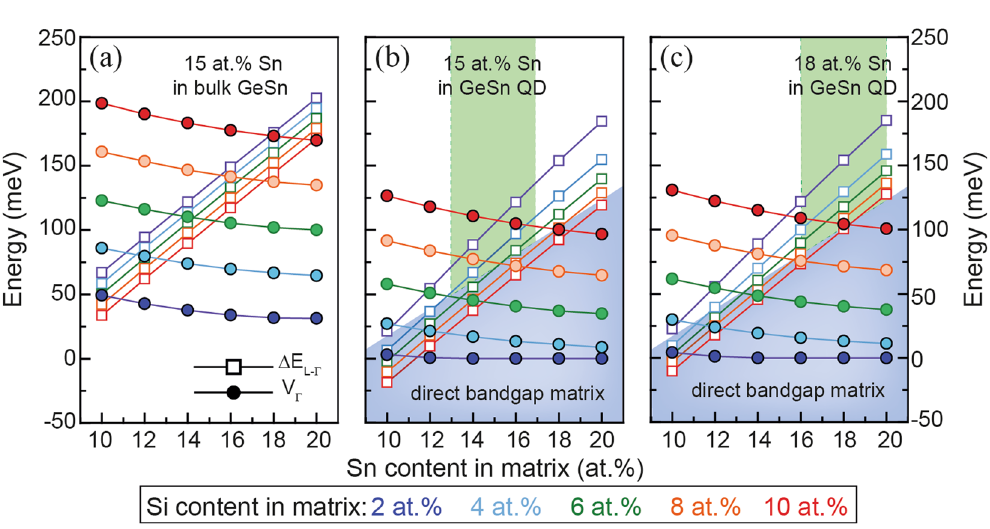
Figure 7. Directness of the potential well (empty squares) and band discontinuity at Γ (solid circles) for ( a ) bulk Ge 0.85 Sn 0.15 /SiGeSn, ( b ) a Ge 0.85 Sn 0.15 /SiGeSn QD and ( c ) Ge 0.82 Sn 0.18 /SiGeSn QD. The meaning of the colored areas is the same as described for MQW